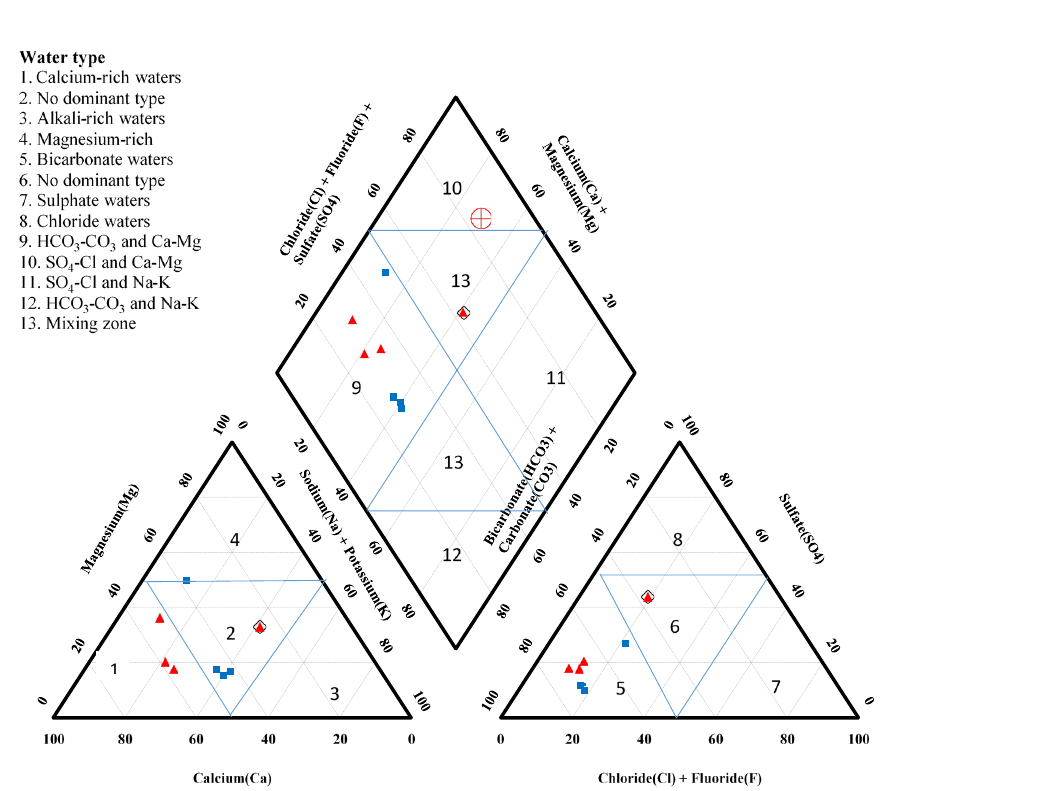
Fig. 4. Piper diagrams for the chemical composition of groundwater samples